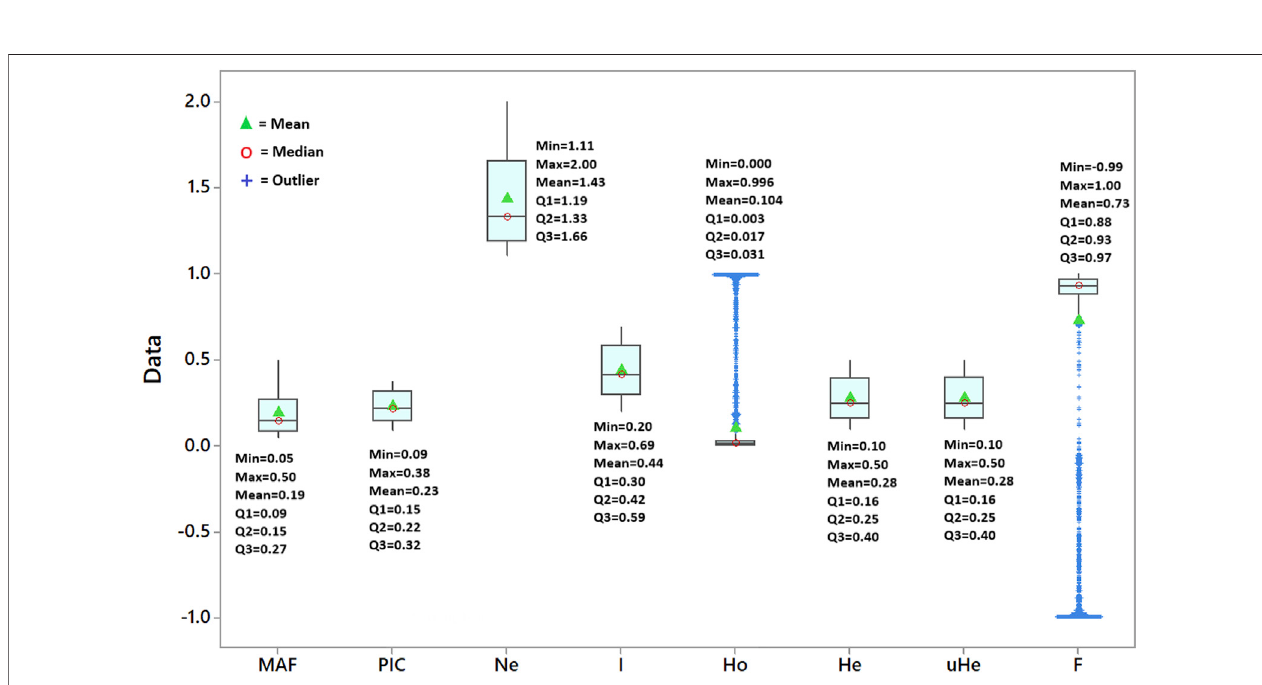
FIGURE 2 | Box plot depicting the variation in minimum allele frequency (MAF), polymorphism information content (PIC), effective number of alleles (Ne), Shannon information index (I), observed heterozygosity (Ho), expected heterozygosity (He), unbiased expected heterozygosity (uHe), and fi xation index (F) of the 5,226 SNP loci across the 288